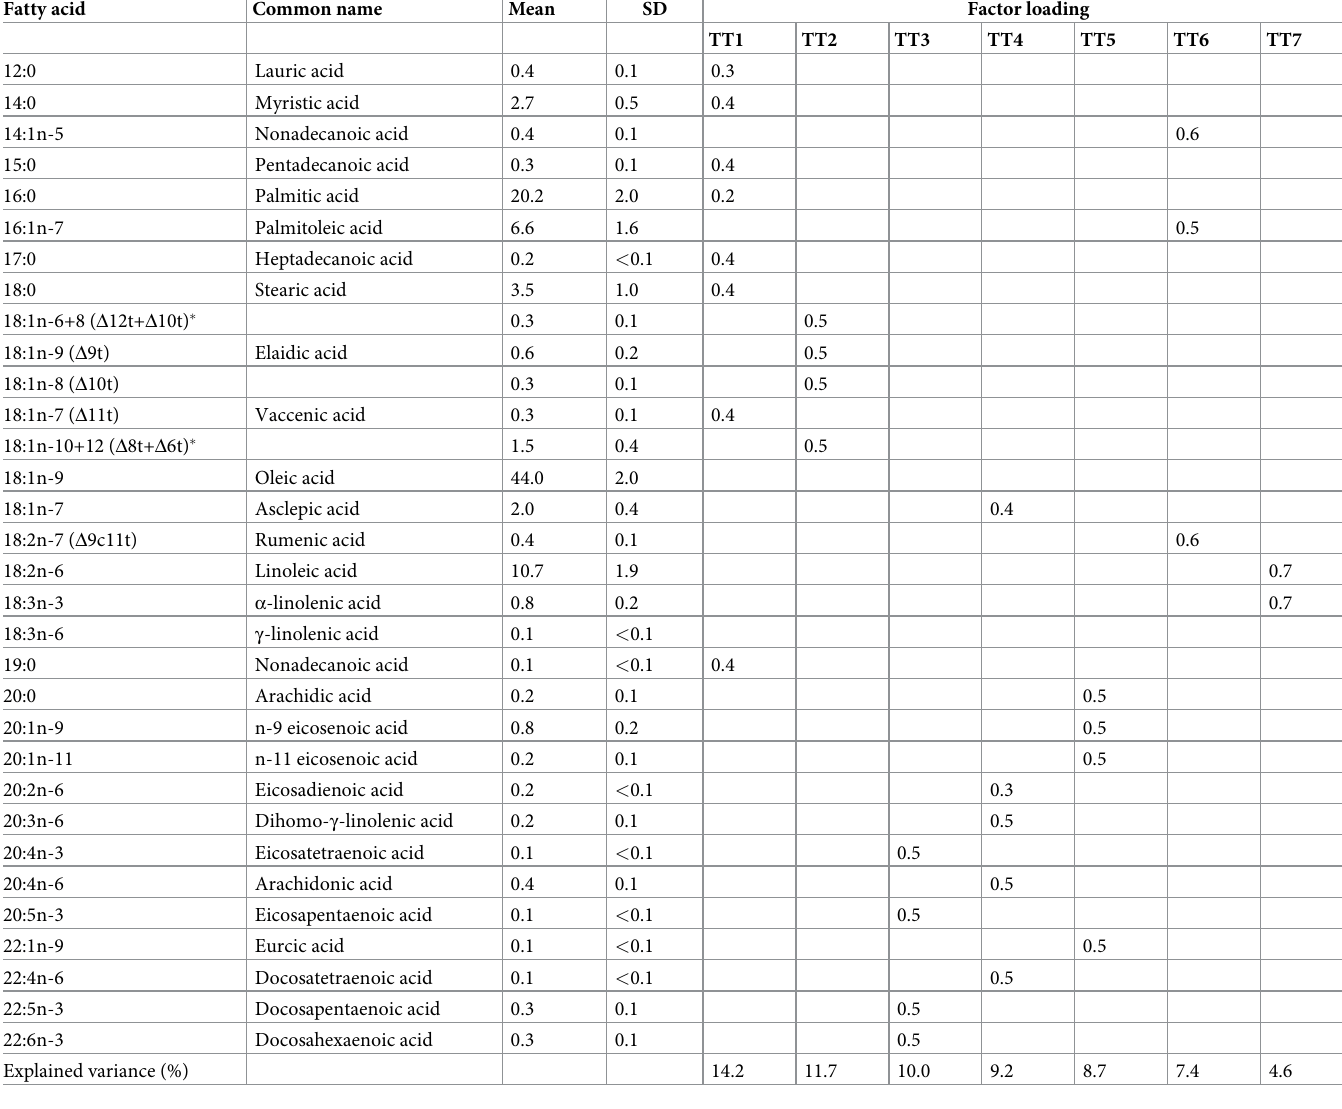
Table 2. Fatty acid loadings on treelet transform